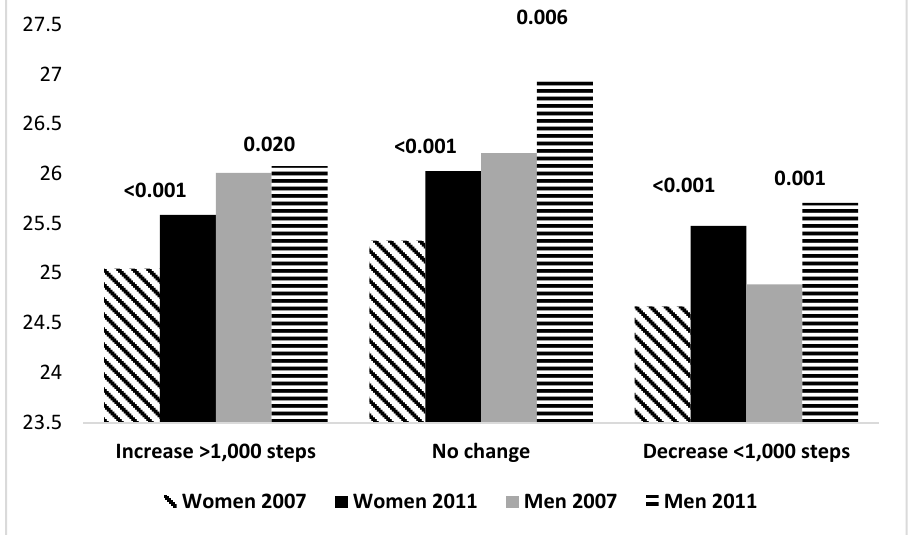
Figure 2. BMI change in the different aerobic step change groups among men and women with p - values, 2007–2011.